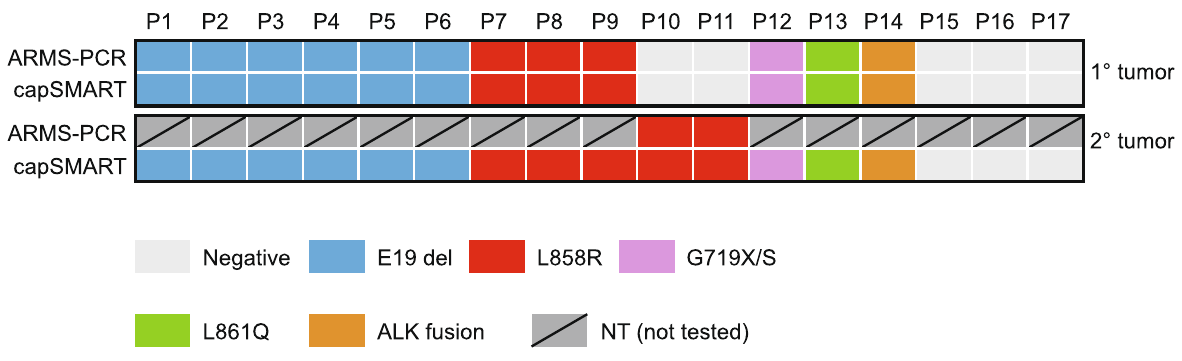
Fig. 3 Concordance of ARMS-PCR and CapSMART for detection of EGFR and ALK fusion